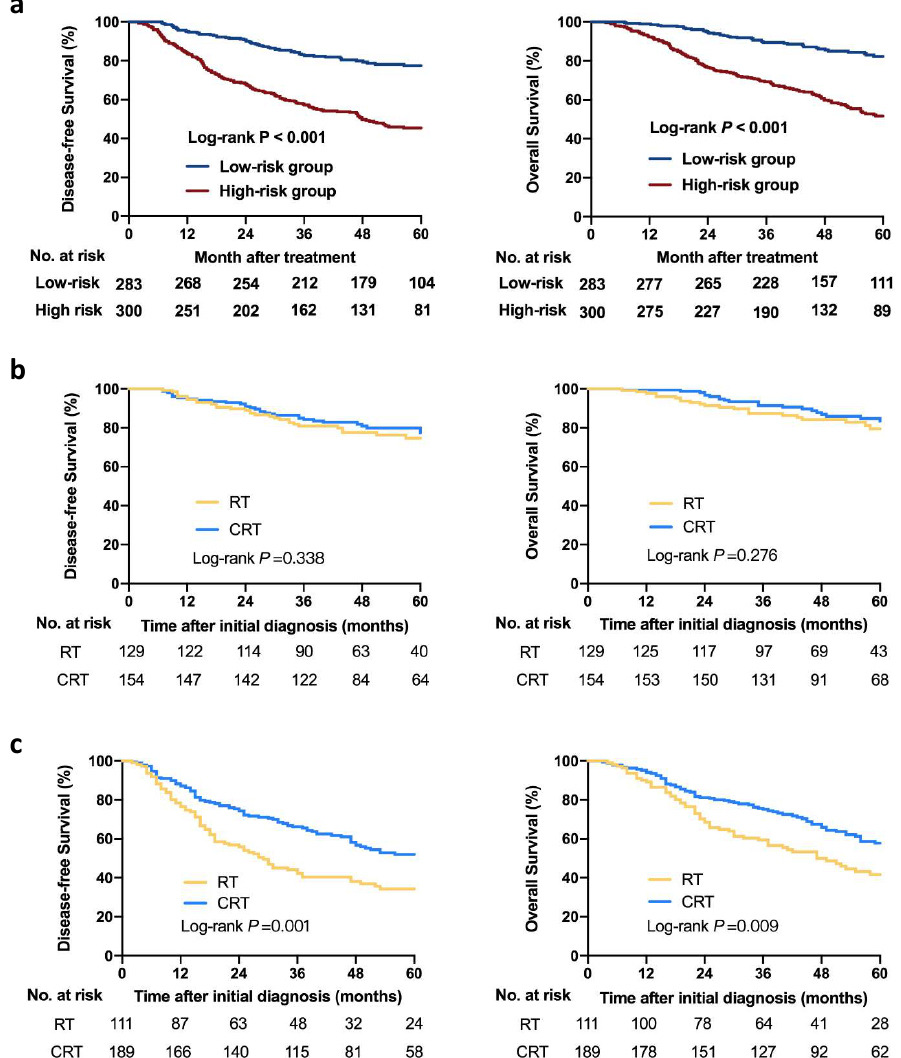
Figure 3. Survival outcomes of the high-risk and low-risk groups generated by the prognostic nomogram. Kaplan–Meier curves for DFS and OS for the two groups ( a ). Survival outcomes of different treatment regimens in the low-risk group ( b ) and the high-risk group ( c ). RT, radiotherapy; CRT, radiotherapy combined with chemotherapy; DFS, disease-free survival; OS, overall survival.